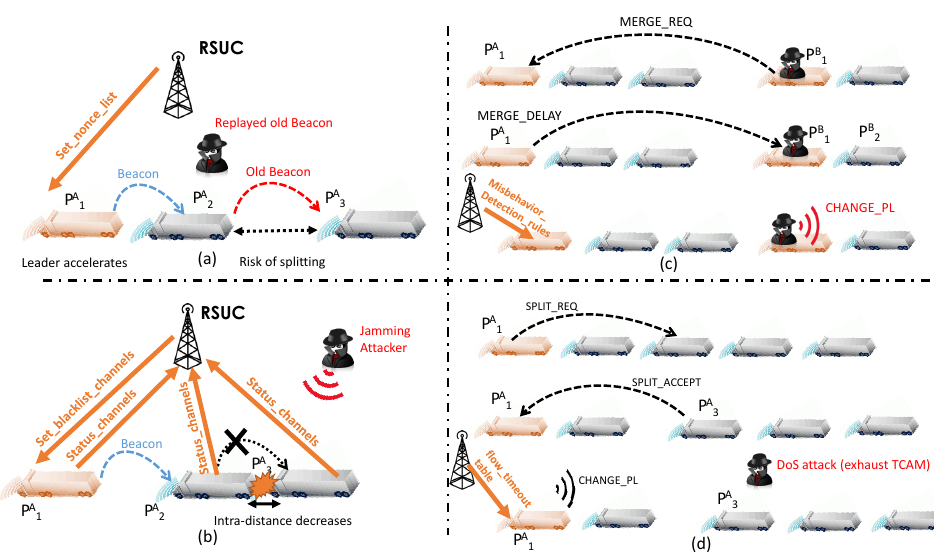
Figure 8. Different attacks on a platoon. ( a ) Replay Attack; ( b ) JammingAttack; ( c ) Insider Attack; ( d ) DoS